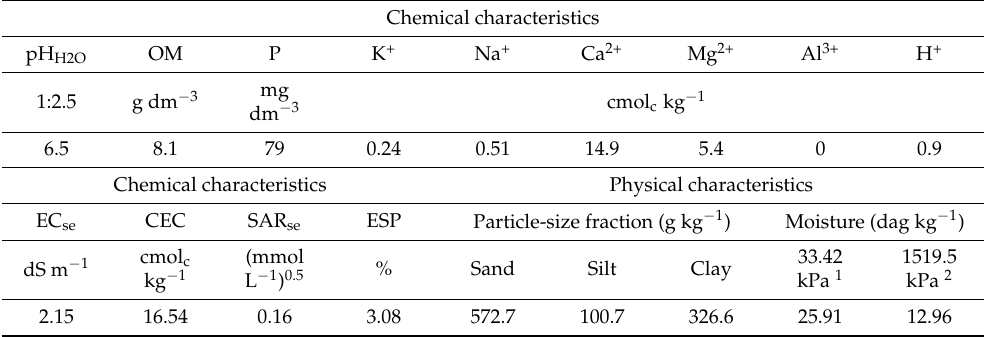
Table 4. Chemical and physical characteristics of the soil (0–0.30 m depth) used in the experiment. Chemical